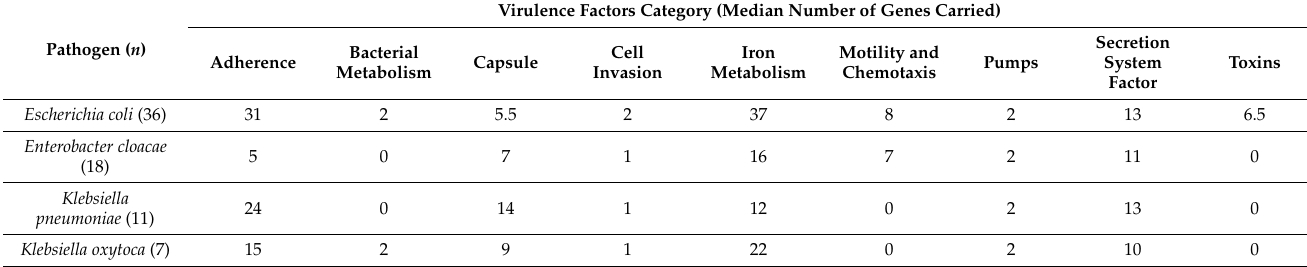
Table 5. Number and percentage of the most represented virulence